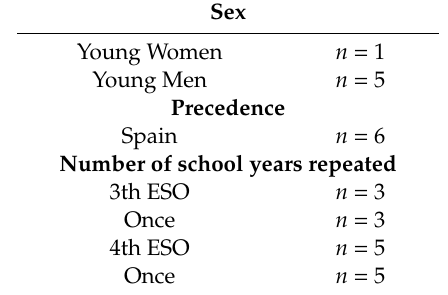
Table 1. Summary of the participants (total n = 6). Sex Young Women n = 1 Young Men n = 5 Precedence Spain n = 6 Number of school years